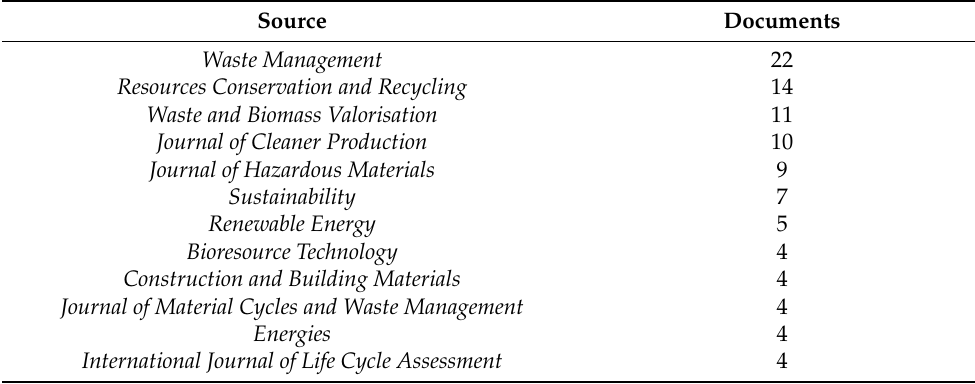
Table 2. Number of documents ordered by